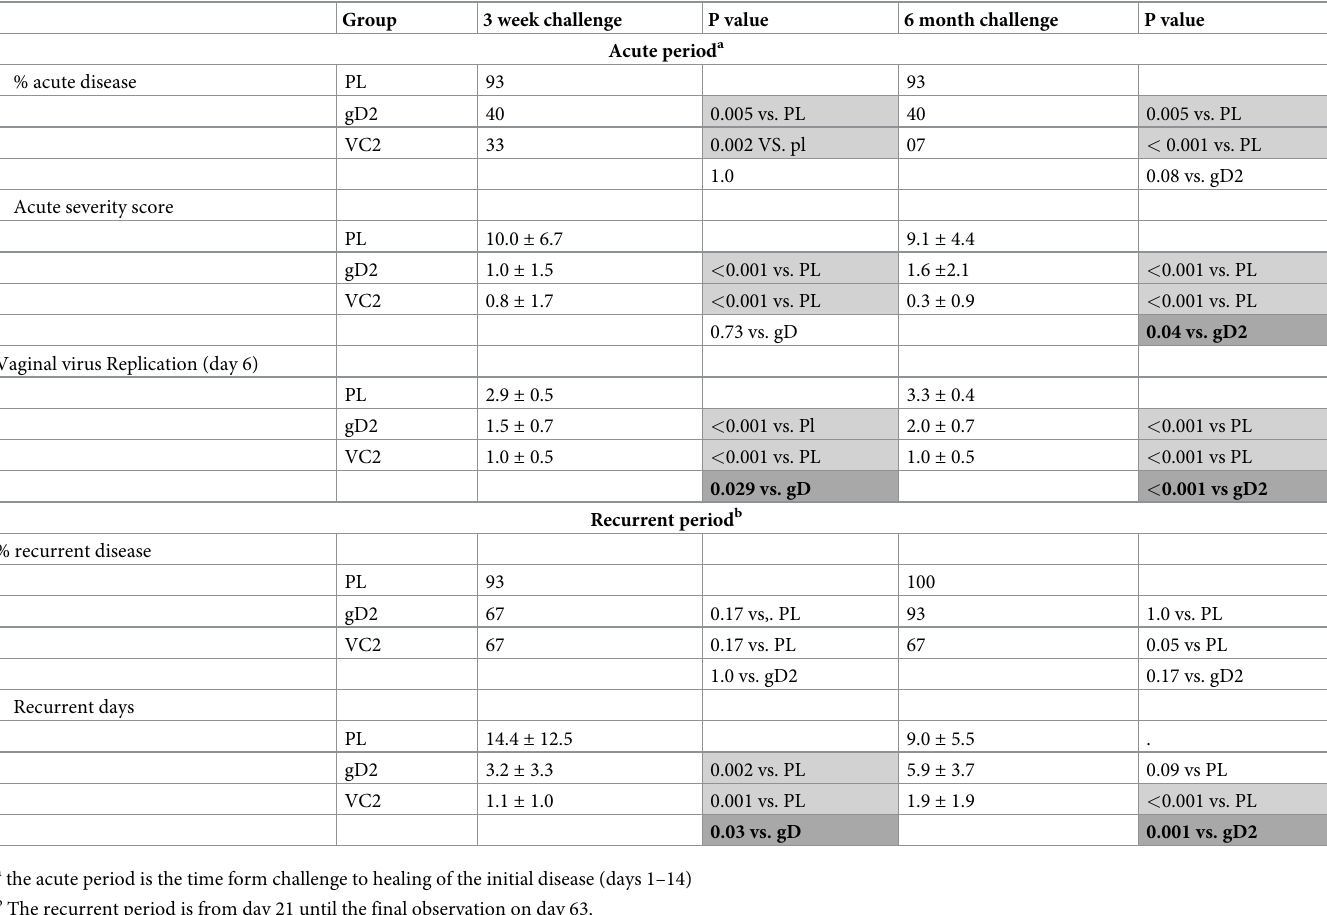
Table 1. Effect of vaccination on acute and recurrent genital HSV-2 infection in guinea pigs challenged